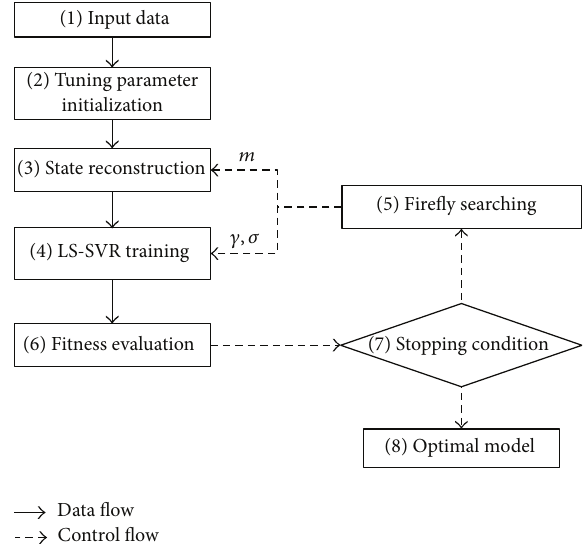
Figure 2: Firefly-tuned least squares support vector regression for time series prediction (FLSVR TSP ).